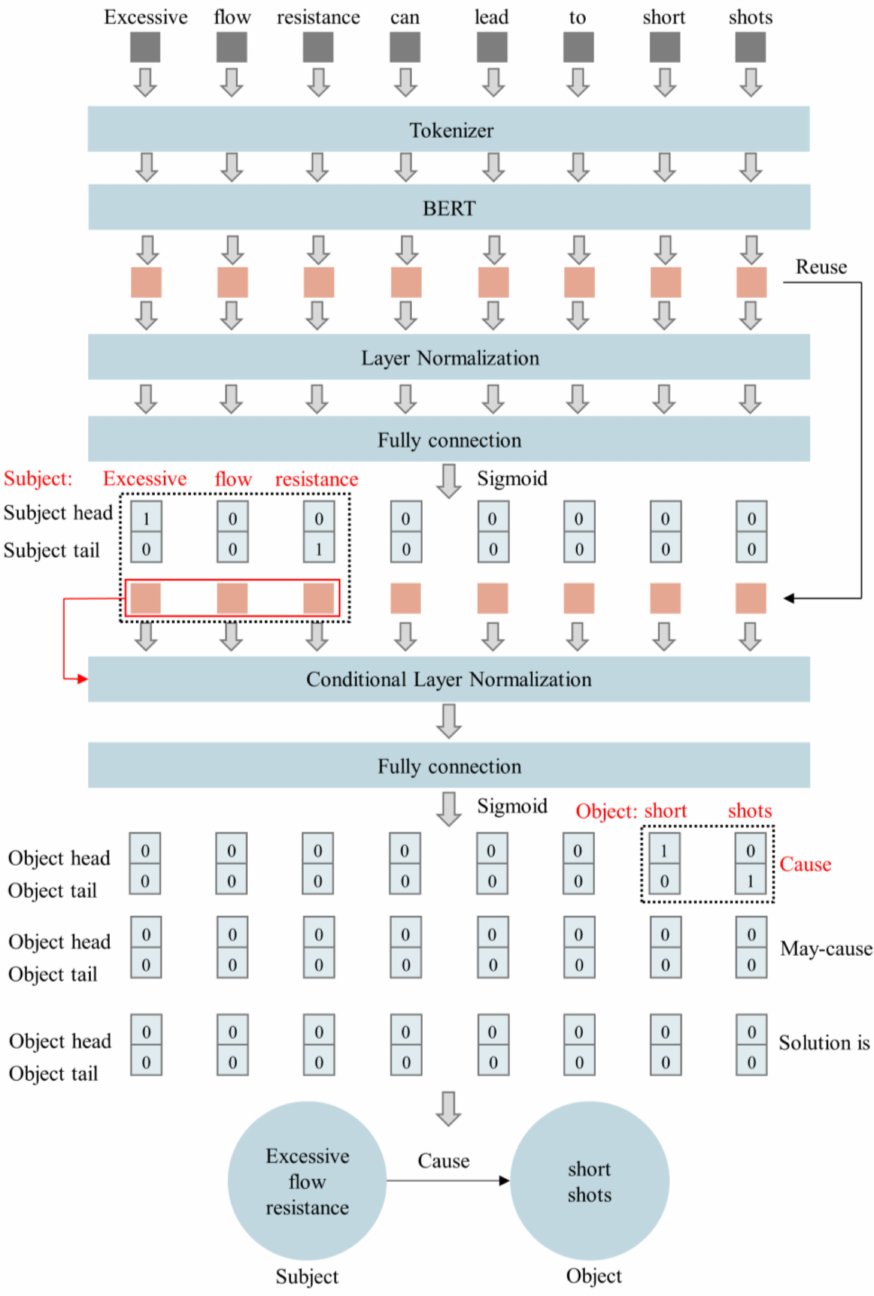
Figure 2. Architecture of the knowledge extraction model. After predicting the head and tail positions of the subject, the model obtained the text features of the subject from the text features generated by BERT based on the head and tail positions, and it input them as the input of the conditional function in the conditional layer normalization to process the text data features generated by BERT. Then, the completed features were input into the fully connected layer, using Sigmoid as the activation function, to generate a three-dimensional matrix to express the head and tail positions of the